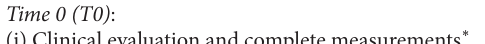
Table 1: The oral hygiene domiciliary scores ∗ . Score